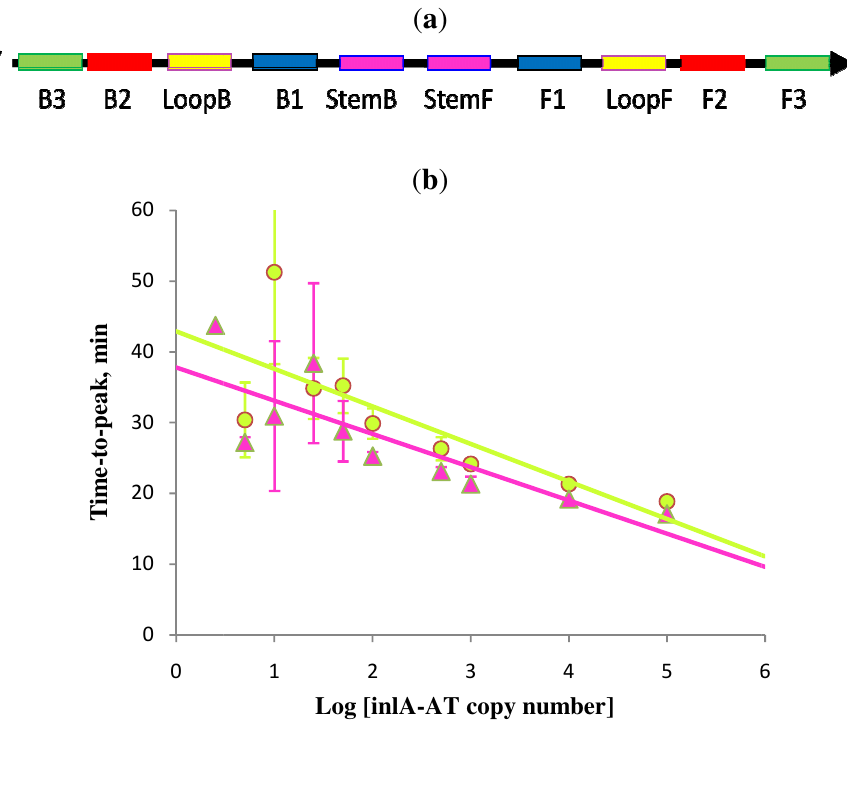
Figure 5. Schematic diagram of all priming sites used in Stem Loop primers